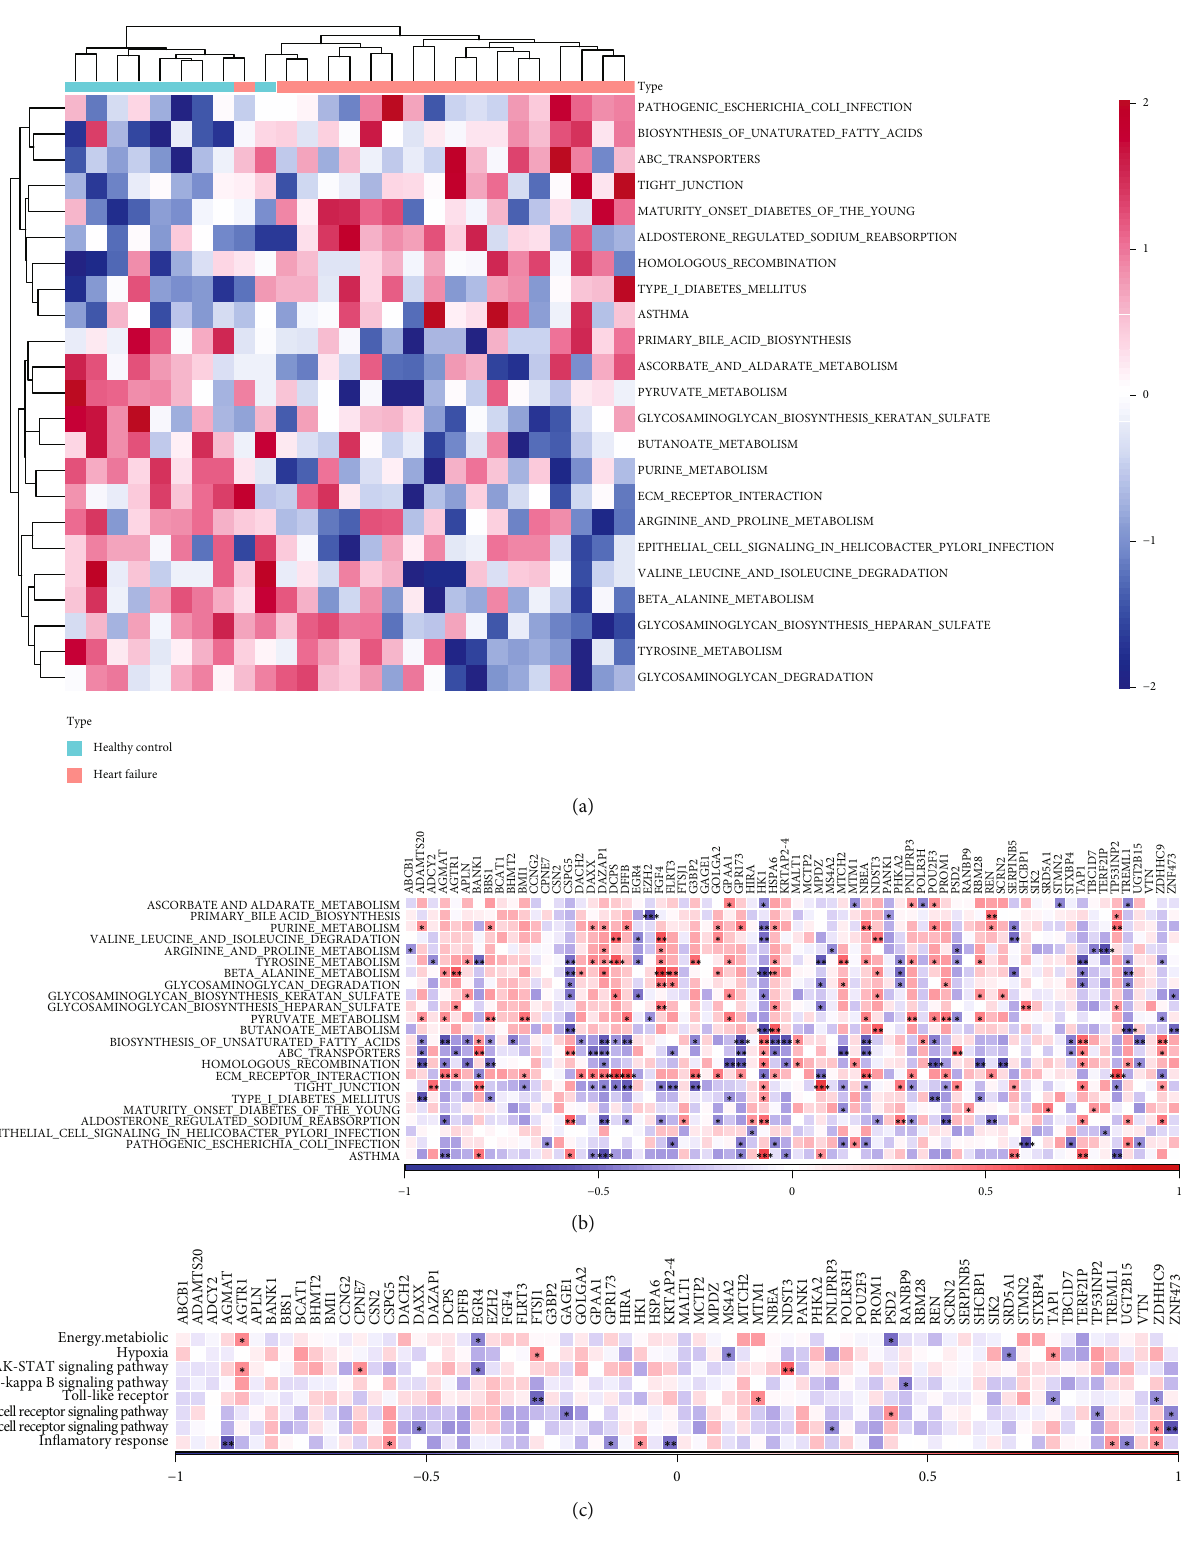
Figure 4: Characterization of pathways abnormally regulated in heart failure: (a) heat map of enrichment scores of pathways signi fi cantly di ff erent in heart failure patients and healthy group by GSVA ( P < 0 : 05 ); (b) heat map of correlation analysis between related pathways and di ff erentially miRNA-regulated di ff erential target genes; (c) heat map of correlation between energy metabolism, hypoxia score, and in fl ammation-related pathways and di ff erentially miRNA-regulated; (d) heat map of correlation analysis between energy metabolism, hypoxia score, and in fl ammation-related pathways and di ff erential miRNA-regulated target